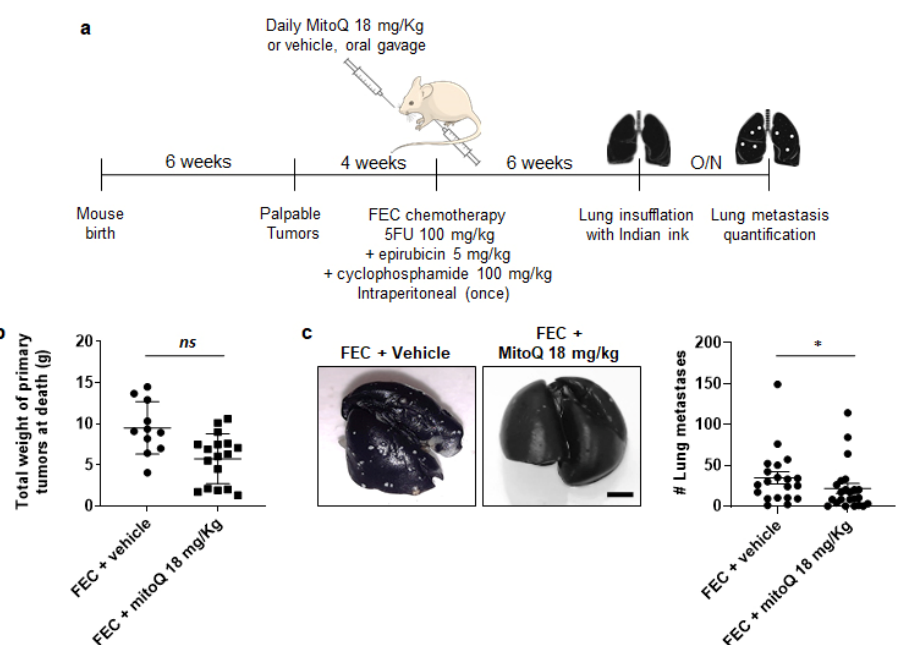
Figure 5. MitoQ prevents lung metastasis in spontaneous metastatic breast cancer in mice. ( a ) Ex- perimental protocol for female MMTV-PyMT mouse treatment. ( b ) Total weight of primary breast tumors collected on the day of sacrifice of MMTV-PyMT mice treated as depicted in a ( n = 11–17). ( c ) Lung metastases in MMTV-PyMT mice treated as depicted in a. Left pictures are representative of lungs insufflated with Indian ink, where metastases appear as white dots quantified in the right graph ( n = 20–23). Bar = 0.5 cm. All data are shown as means ± SEM. * p < 0.05, ns : p > 0.05 compared to vehicle; by Mann-Whitney test ( b , c ).